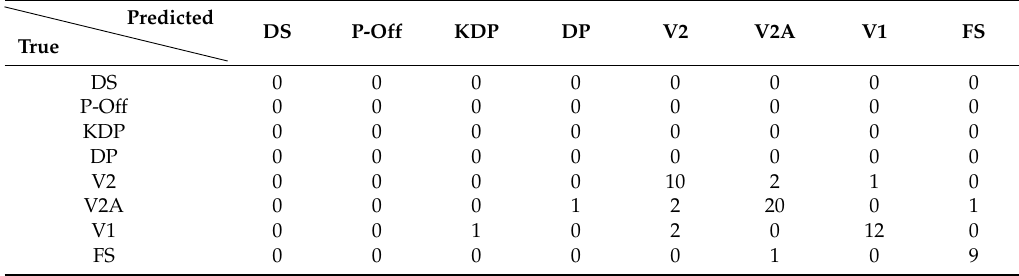
Table A4. Confusion matrix for the flat course, skating style validation set of skier 2 when using the sports biomechanics configuration of sensors.